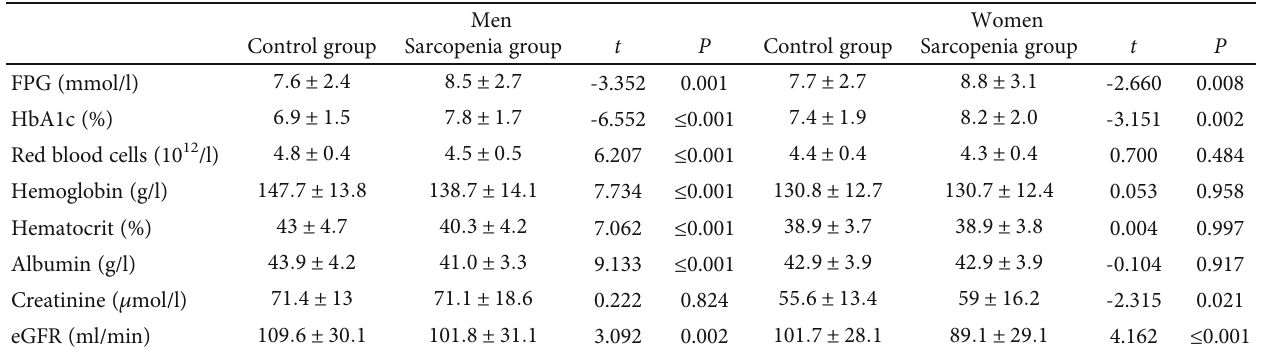
Table 2: Laboratory measurements of T2DM participants in the sarcopenia group and control group strati fi ed by sex.